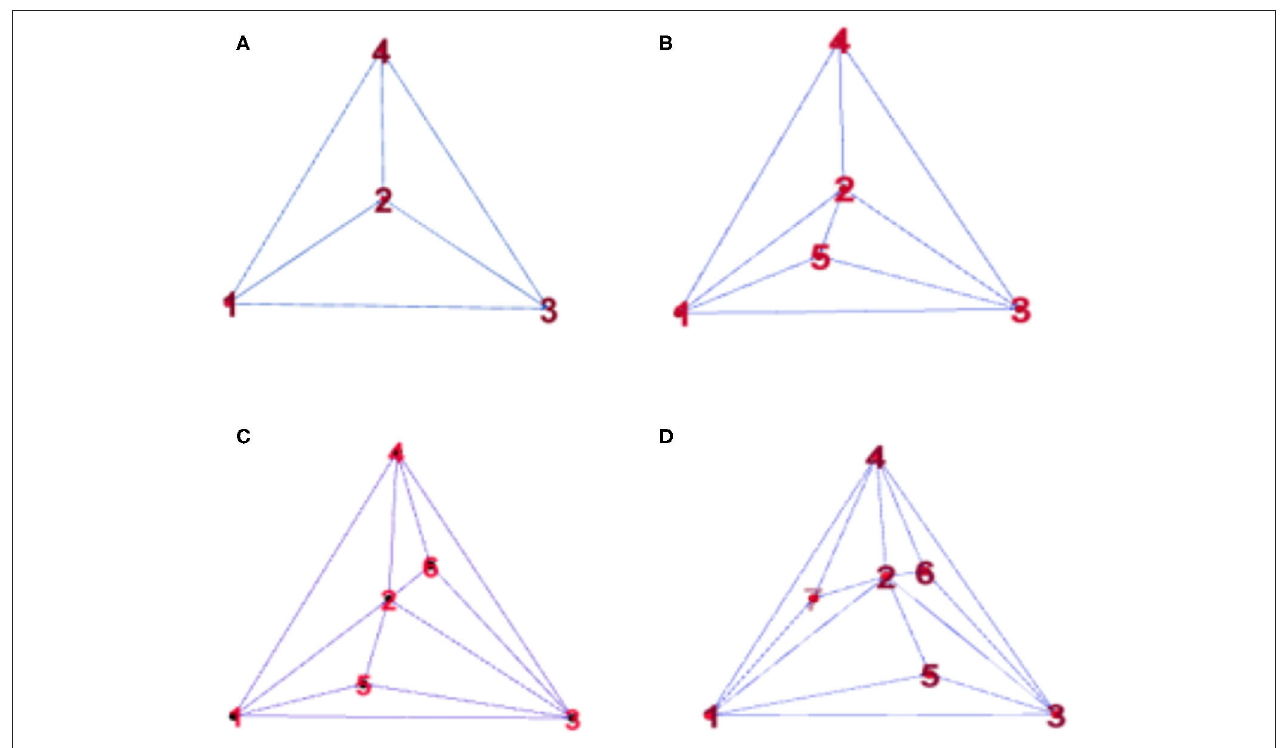
FIGURE 1 | Snapshots of a random Apollonian network (RAN) at: (A) t = 1, (B) t = 2, (C) t = 3, (D) t =